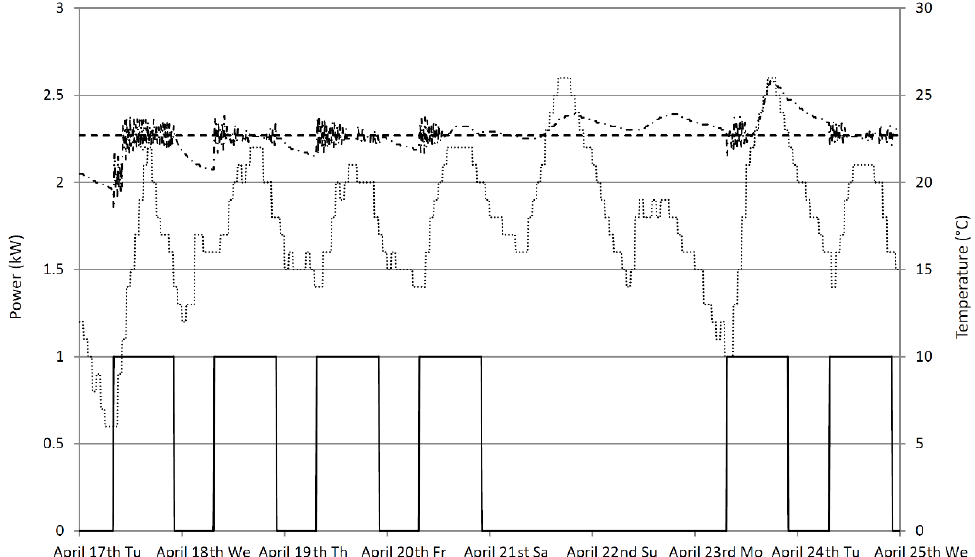
Figure 7. Air handing units (AHU) ventilation operation without the EEM.